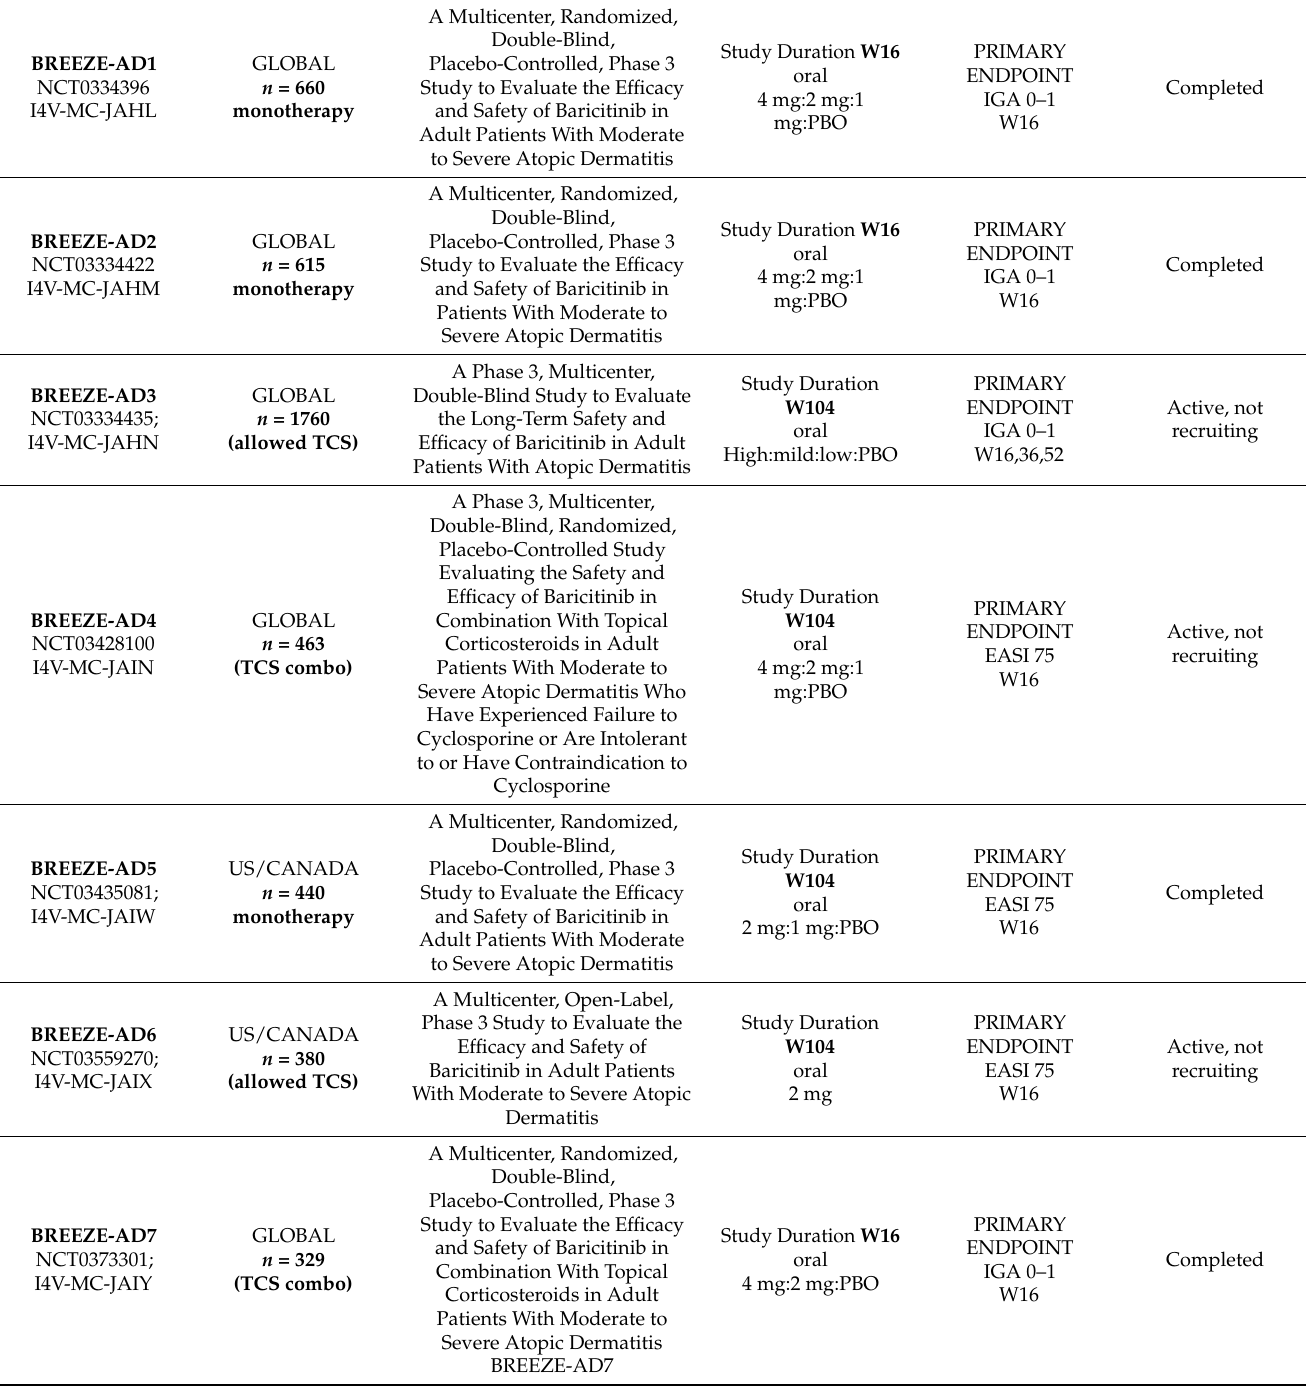
Table 1. Main characteristics of the BREEZE-AD program phase III studies.